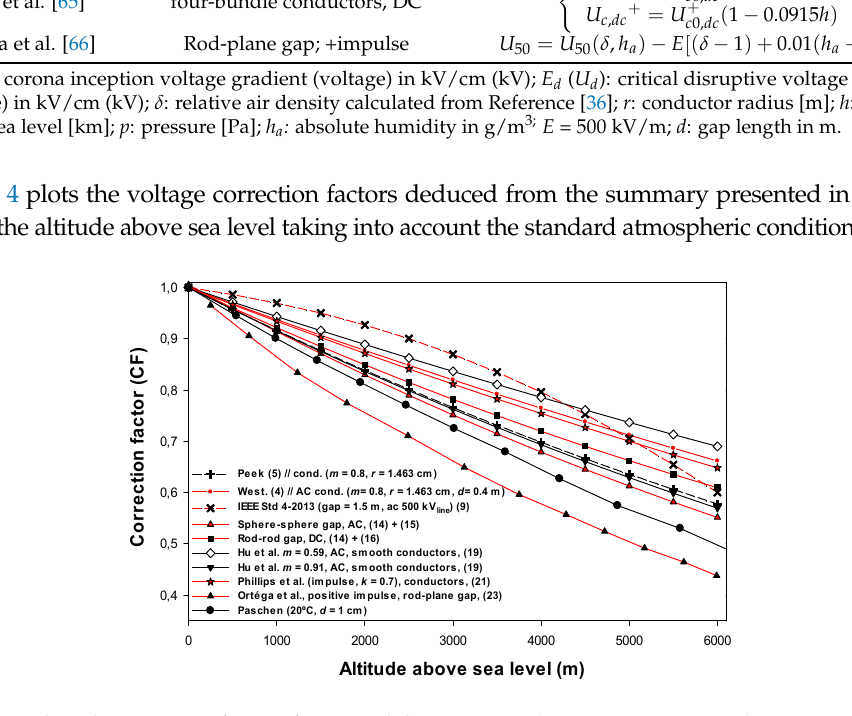
Figure 4. Altitude correction factors for critical disruptive and corona inception voltages according to the corrections summarized in Table 4 for r = 2.926/2 cm, m = 0.8, d = 40 cm, h a = 11 g/m 3 . Black lines are from equations based on corona inception conditions whereas red lines are from equations based on disruptive conditions.